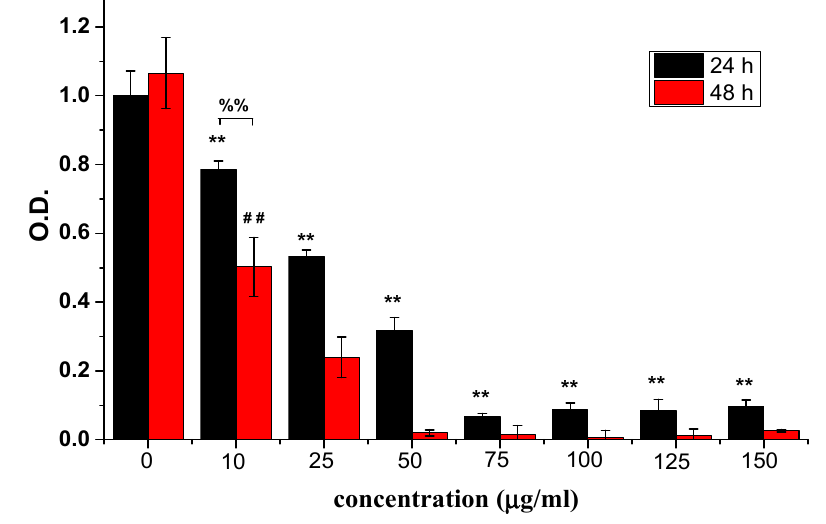
Figure 4. Relative cell numbers determined by the absorbance (OD) value using CCK-8 at 24 and 48 h. Breast cancer cells (MDA-MB-231) were treated with ABMP at different concentrations, i.e., 0, 10, 25, 50, 75, 100, 125, and 150 µ g/mL. The experiments were carried out in quadruplicate. Double asterisks (**) and double pounds (##) refer to statistical significance p < 0.01 compared with control groups. Double percent (%%) refers to a statistical significance of p < 0.01 between the OD values after seeding for 24 and 48 h.